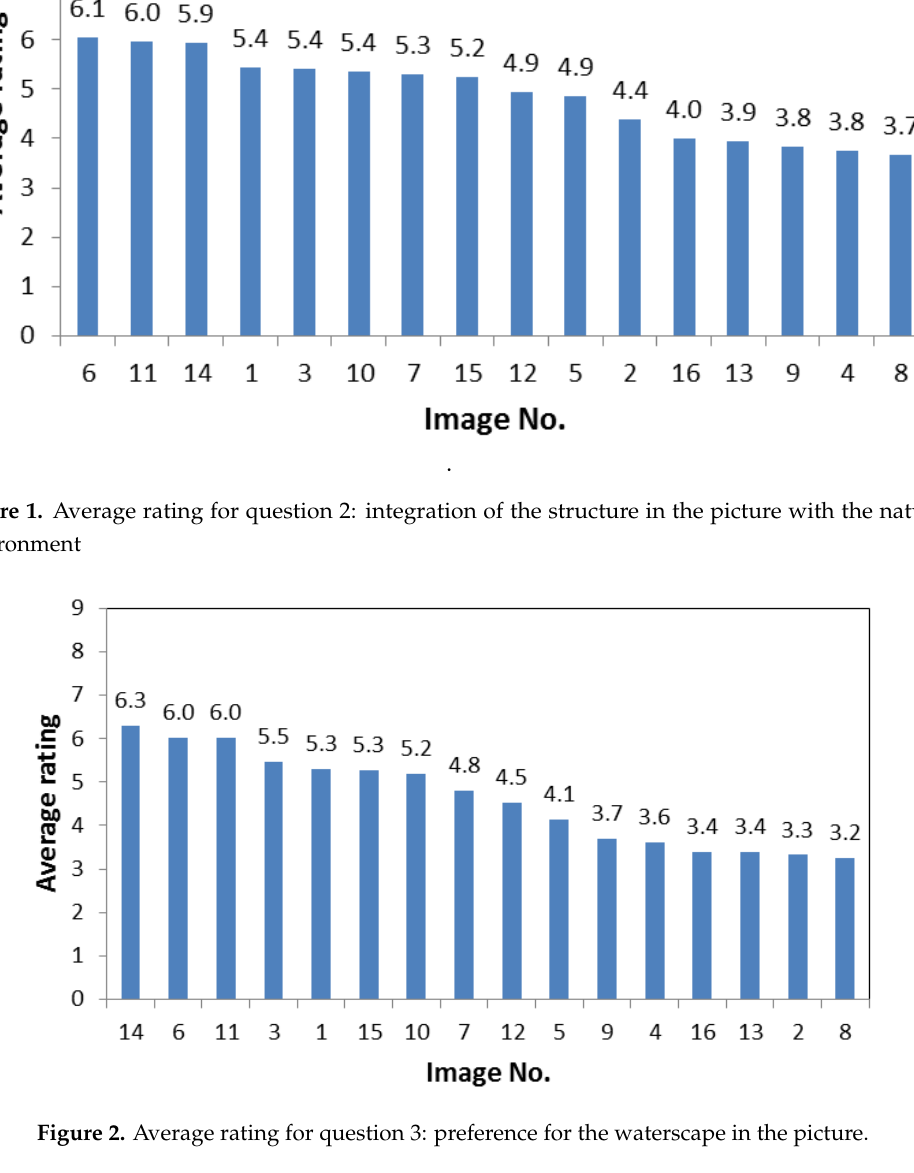
Figure 2. Average rating for question 3: preference for the waterscape in the picture.